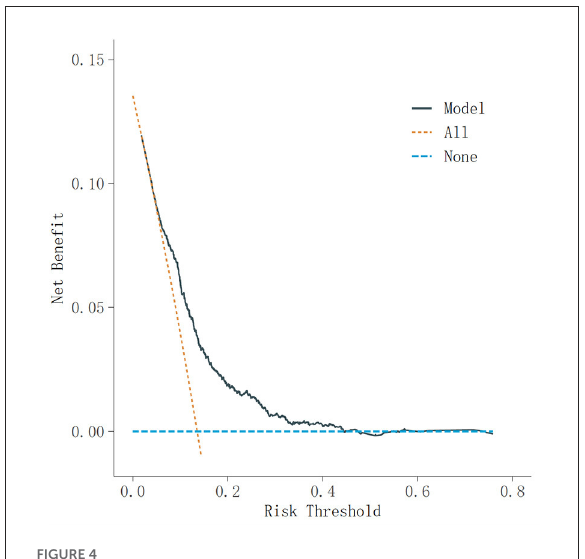
FIGURE4 Decision curve analysis of the prediction model for frailty detection. DCA, decision curve